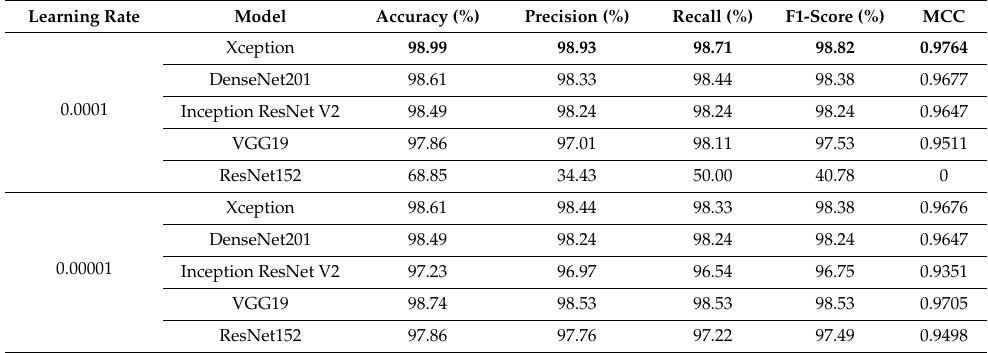
Table 4. Performance metrics collected for magnification-independent binary classification; the highest results are shown in